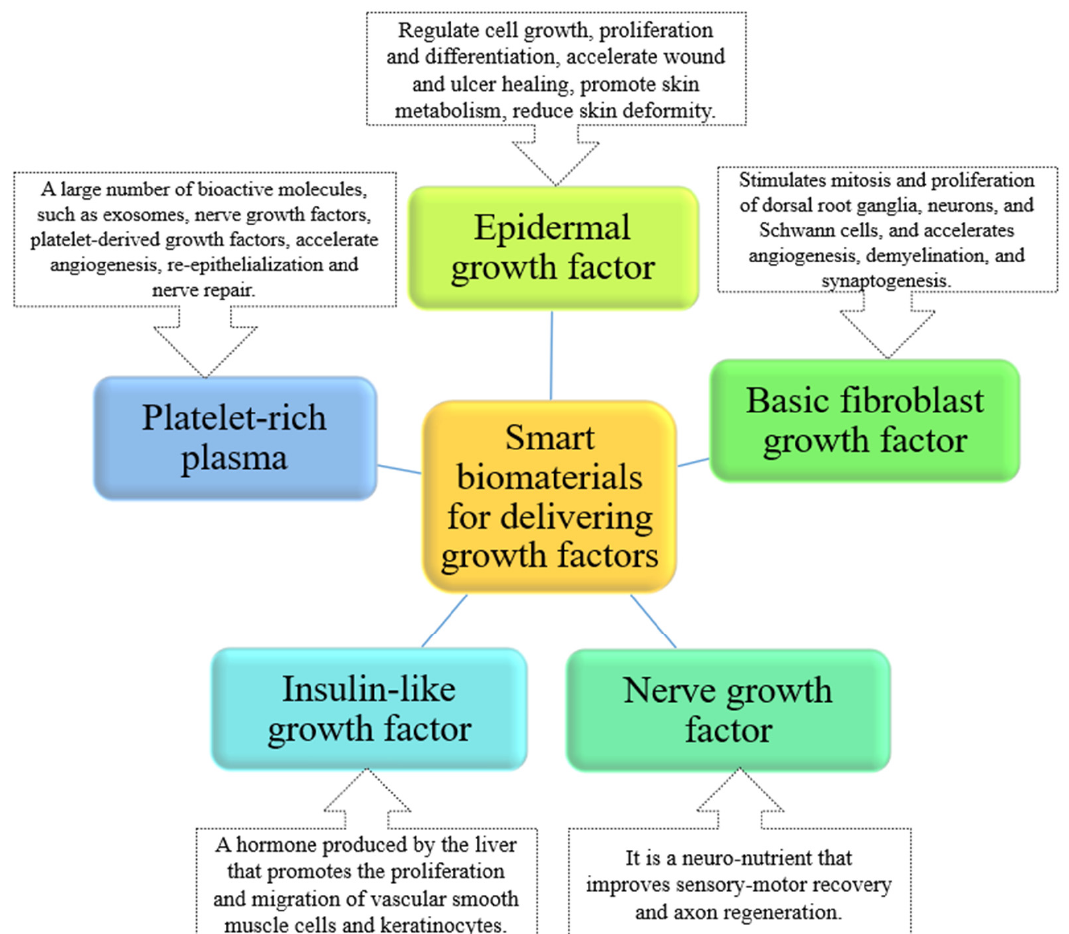
Figure 4. Summary of the key role of bio-intelligent materials in delivering growth factors in heal- ing.